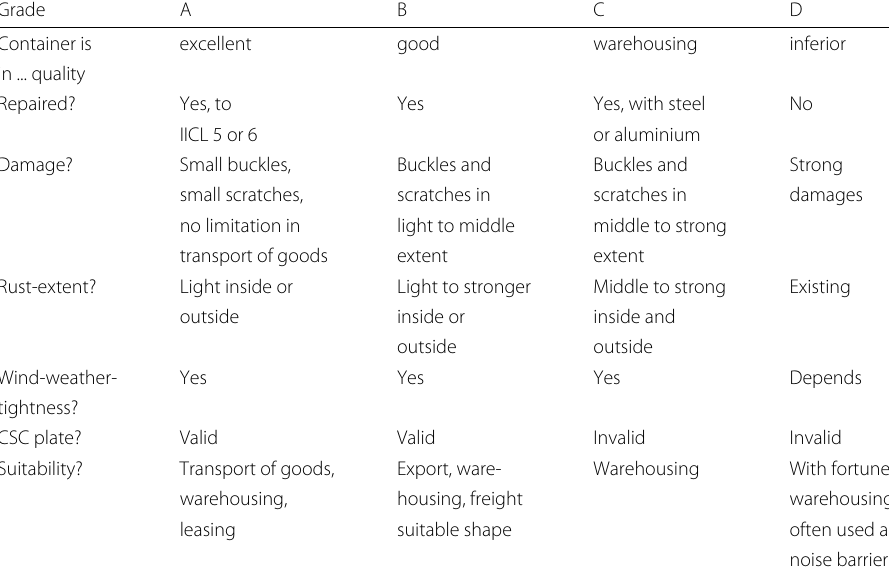
Table 2 Criteria for damage grades; Data source: (Containerbasis 2016b) Grade A B C D Container is excellent good warehousing inferior in ... quality Repaired? Yes, to Yes Damage?